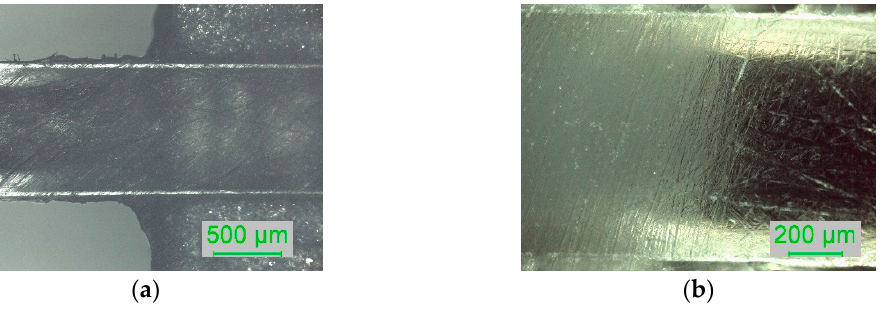
Figure 5. Optical microscopy images of the interface between the sensing region and the unpolished POF: ( a ) sensor D3 (P320, P600, 12 µ m grit size); ( b ) close-up of sensor D1 (P320 and